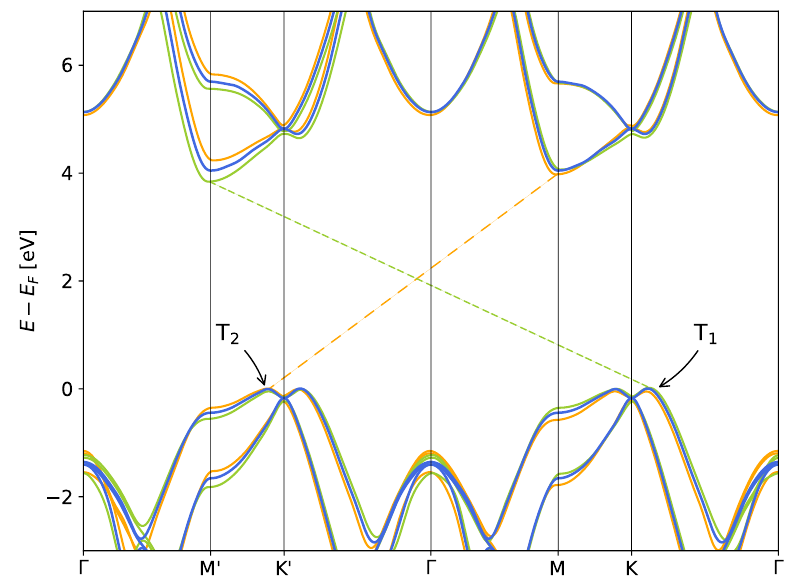
Figure 5: [ Color online ] Details of the electronic band structure under the maximum stretch and compression considered in the manuscript. Blue lines are at equilibrium, green lines at 2.5% stretch and orange lines at 2.5% compression. We report also the location of the new indirect gaps in the two cases. Notice that at equilibrium all indirect transitions between the different K and M points are